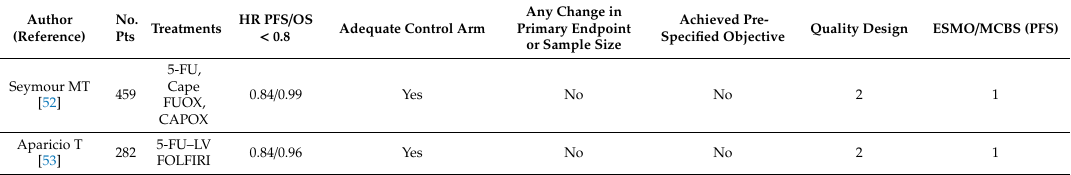
Table 1. Phase III trials comparing fluoropyrimidines monotherapy or doublet chemotherapy in metastatic colorectal cancer in elderly